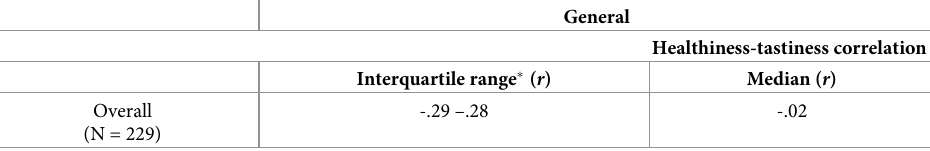
Table 4. Range and median values for the general correlation between healthiness and tastiness ratings.